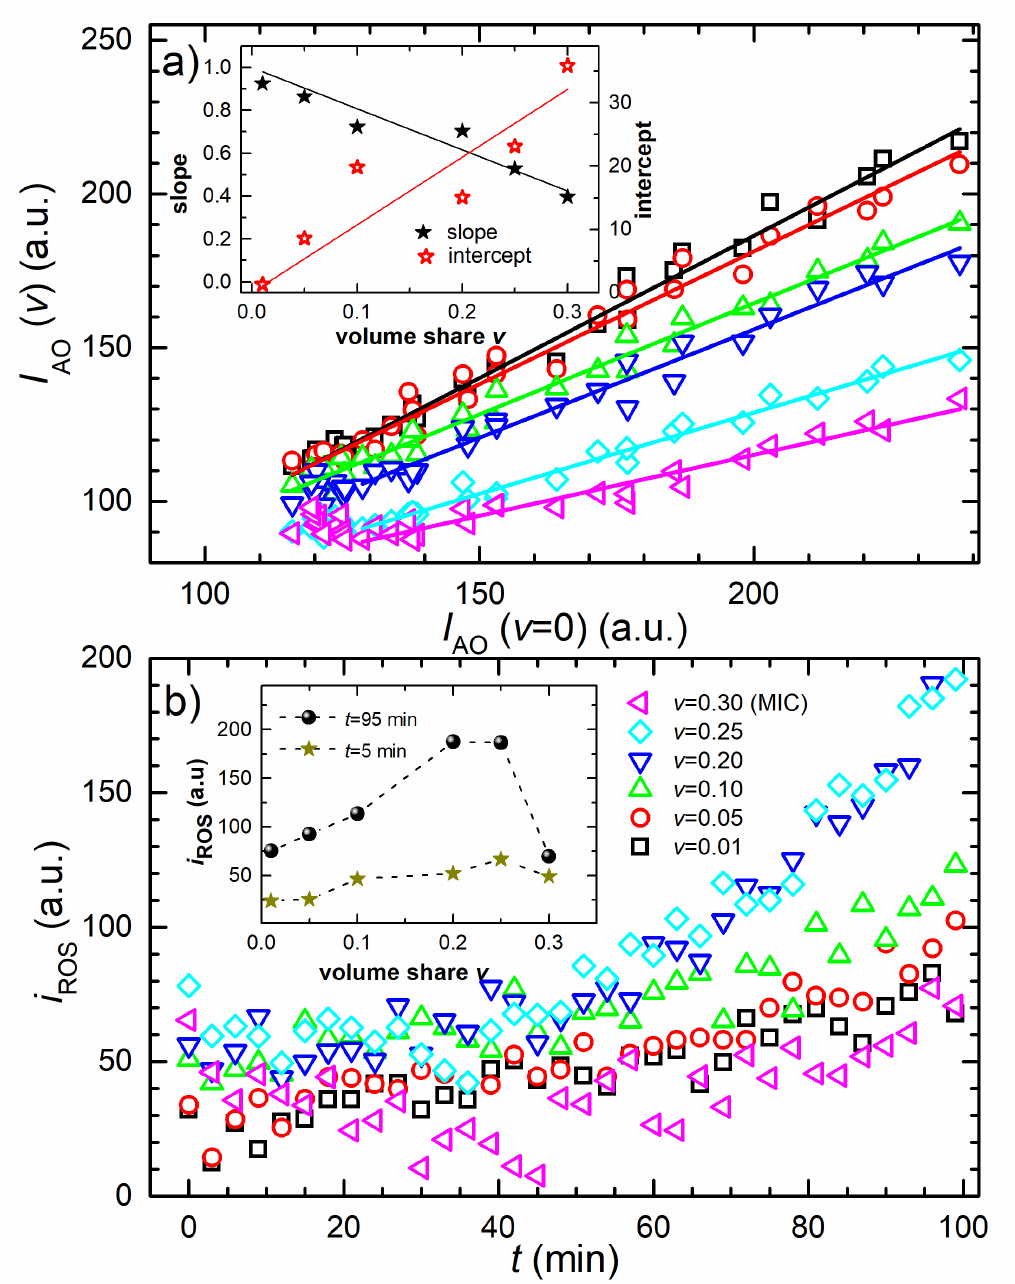
Figure 3. Fluorescence data analysis . ( a ) The correlation between v = 0 and v (cid:44) 0 fluorescence intensity data from Figure 2a. The symbols are the experimental data and the lines are the best linear fits where the lines’ length denotes the data range selected for each fit. The inset gives the slope (full stars) and the intercept (open stars) of the fits as a function of AgNPs concentration. Each data set is fitted to a line. ( b ) ROS fluorescence intensity versus time. Time evolution of the AgNP-induced bacterial ROS fluorescence ( i ROS ) signal extracted from the raw data, as described in the Discussion section. The inset shows the concentration dependence of the i ROS average for the first and last three time points. The AgNPs concentration is given in the